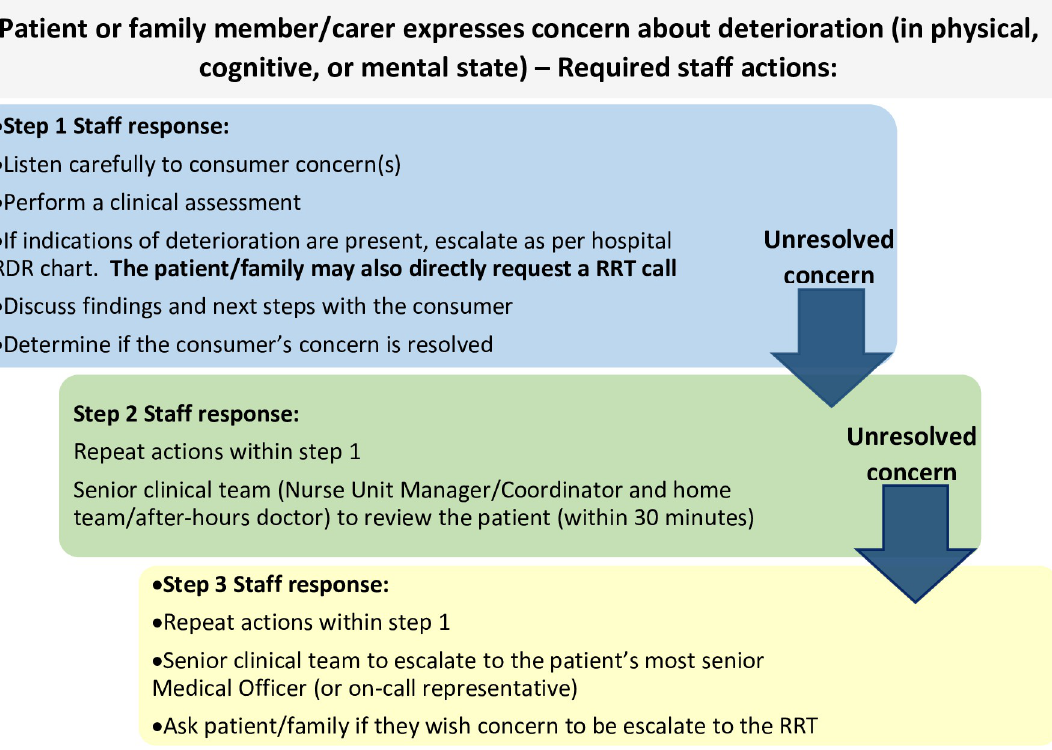
Fig 1. Local consumer escalation pathway for patient/family/carer concern of acute clinical